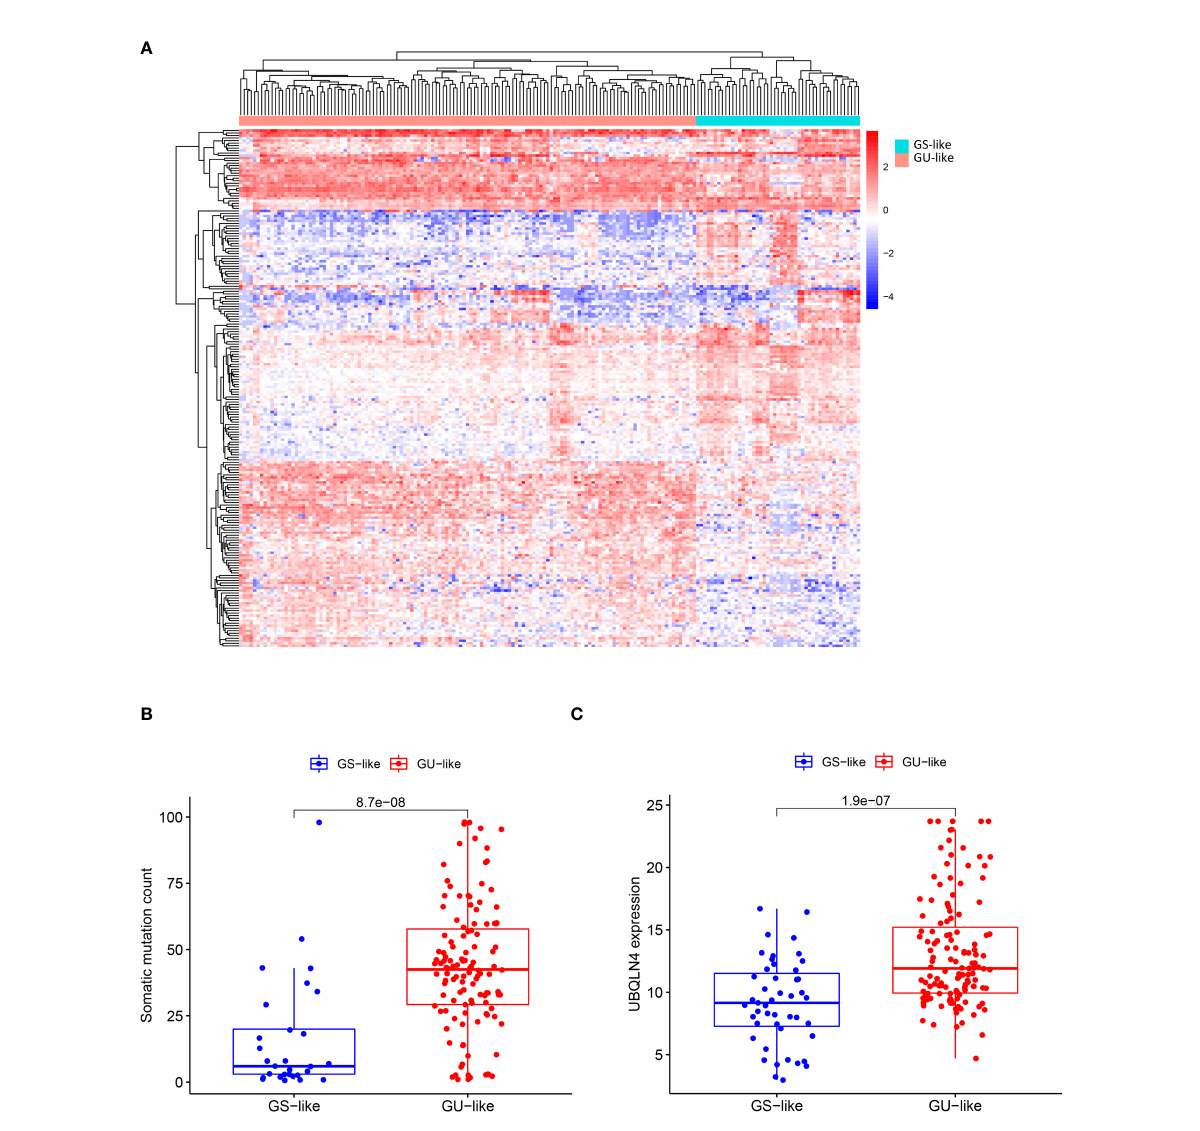
FIGURE 1 Identi fi cation of genomic instability-related lncRNAs in pancreatic cancer patients. (A) Unsupervised clustering of 178 patients with Pancreatic ductal adenocarcinoma based on expression patterns of 206 candidate genomic instability-associated lncRNAs. The red cluster on the left is GU-like group and the blue cluster on the right is GS-like group. (B) Box plot of somatic mutations in the GU-like group and GS-like group. Somatic cumulative mutations were signi fi cantly higher in the GU-like group than in the GS-like group. (C) Box plot of UQLN4 expression levels in the GU-like group and GS-like group. The expression level of UBLNQ4 was signi fi cantly higher in the GU-like group than in the GS-like group. Horizontal line: median value. Statistical analysis was performed using the Mann-Whitney U